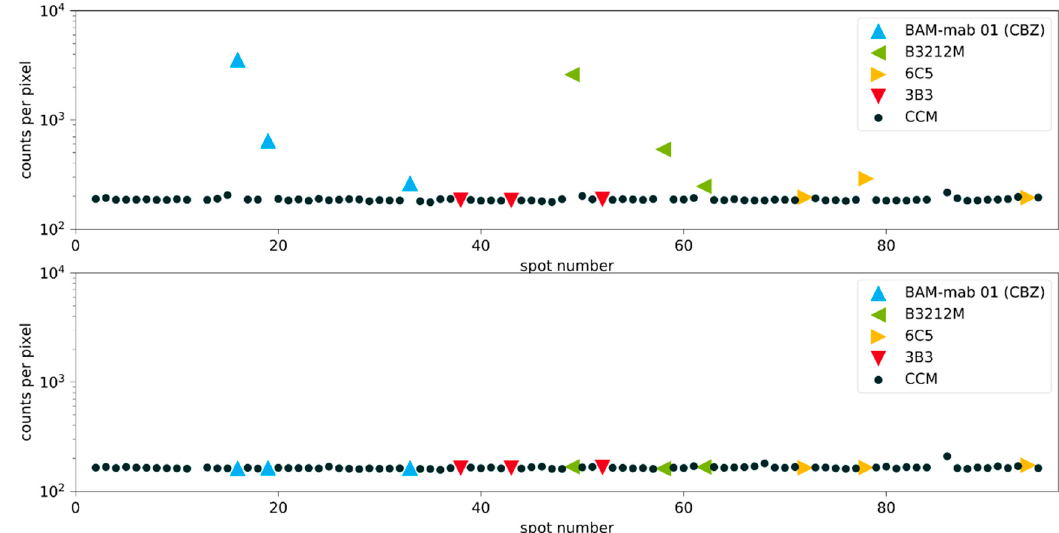
Figure 8. Clone screening with inhibition experiment. Signals for the spots on the Cys-Protein-G glass slide. The upper figure shows the non-competitive binding of the fluorescently labeled hapten (analyte) to the immobilized antibodies. The lower figure shows the same experiment under competitive conditions with an excess of hapten (27 mg L − 1 analyte CBZ). Known monoclonal antibodies diluted in cell culture medium are color-coded, accordingly. CCM: Cell culture medium (negative controls). Blank measurements with slightly increased signals are caused by carryover effects, which can be easily identified and eliminated.